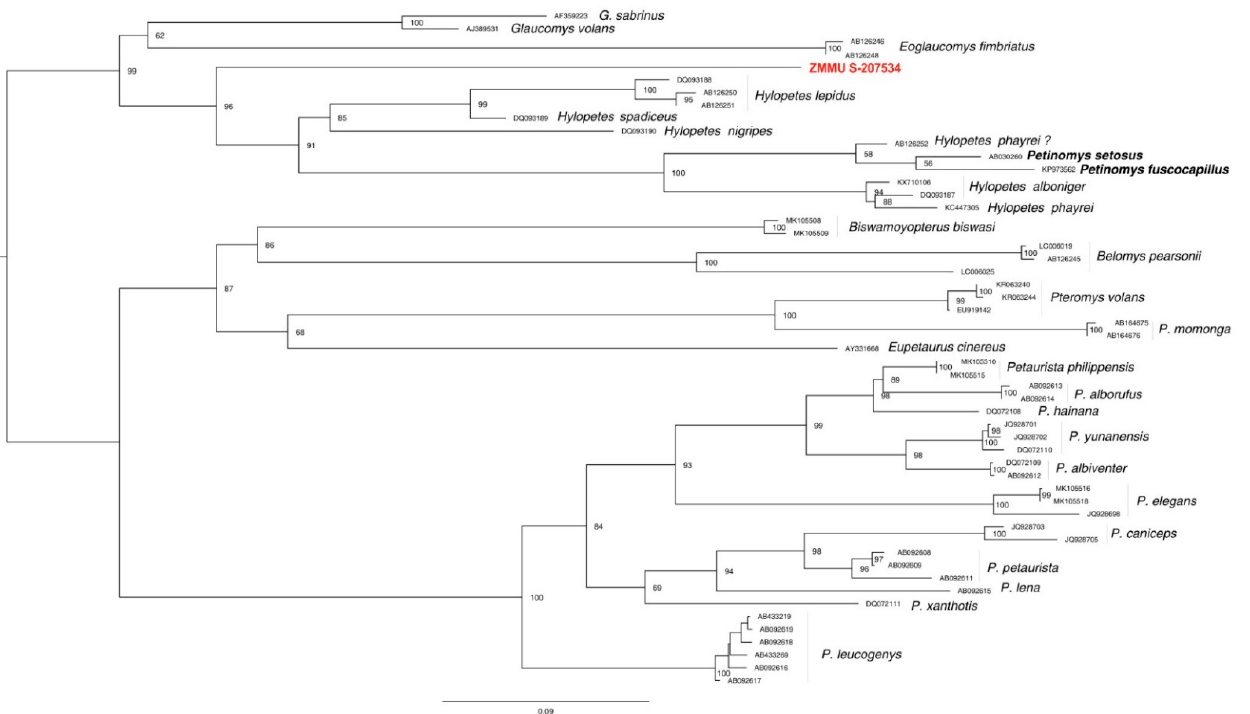
Figure 5. Phylogenetic ML tree for the Pteromyini tribe reconstructed from alignment of the mito- chondrial gene cytb . Numbers on tree nodes indicate bootstrap values.